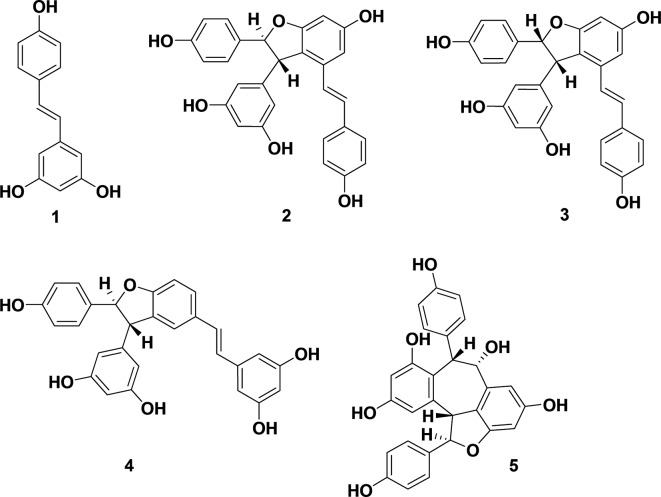
Biologically active stilbenes: resveratrol (1), ε-viniferin (2), (E)-ω-viniferin (3), δ-viniferin (4), and balanocarpol (5).